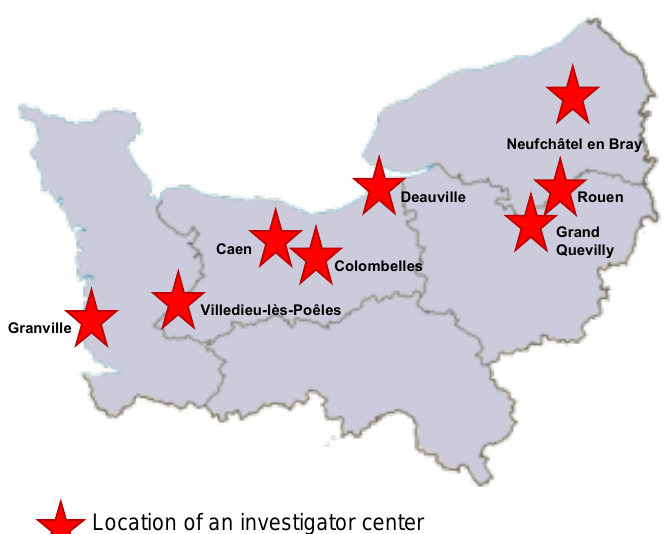
Figure 1. Repartition of the eight investigator centers in Normandy, France.